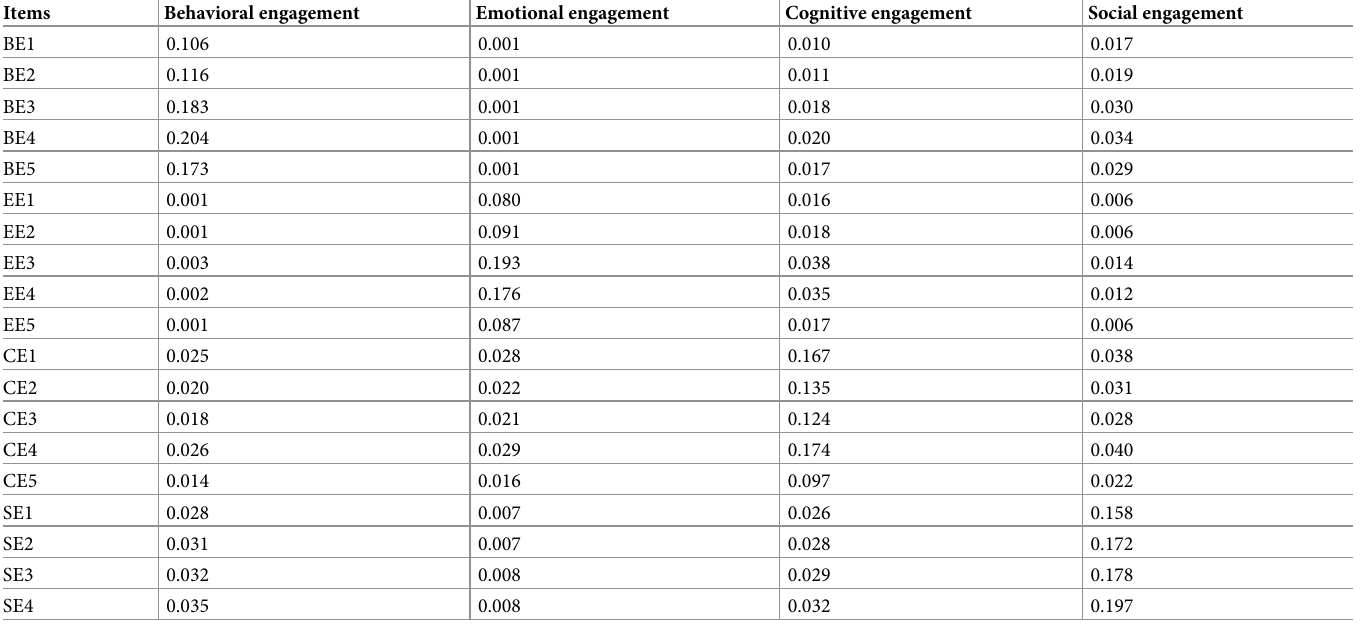
Table 4. Factor score weights of each item with all latent